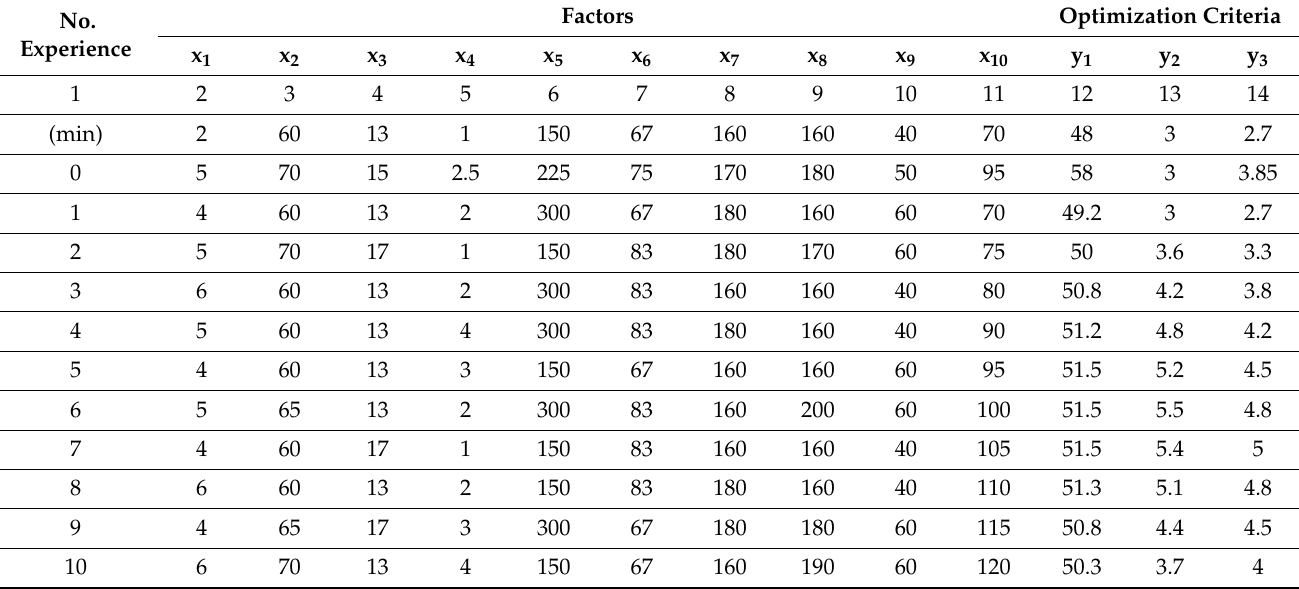
Table A1. Matrix for planning recovery